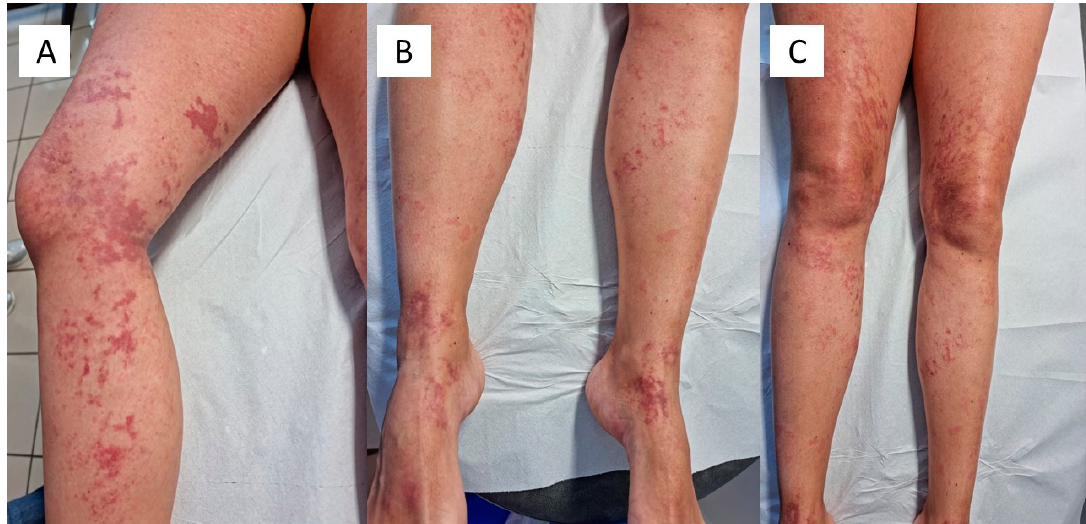
Figure 1. ( A – C ). Clinical spectrum of the purpuric rash in the lower limbs of the patient described. Note the different distribution of the lesions.